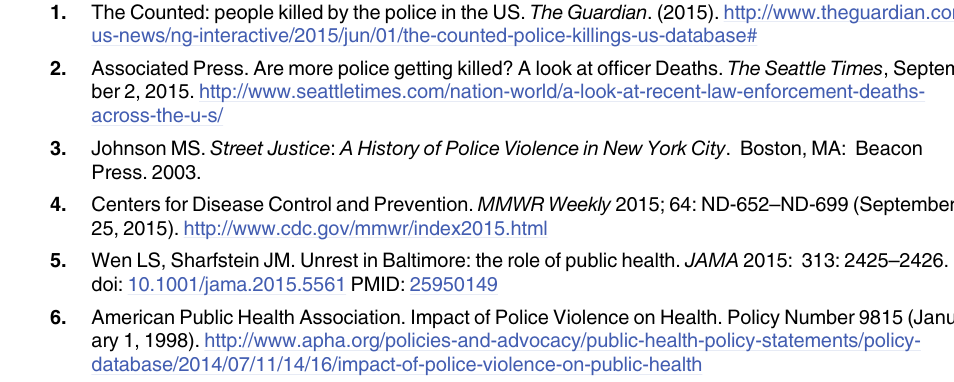
S2 Table. US deaths due to legal intervention: national and city-specific 5-year average annual rate (per 100,000) among US black men and white men ages 15 – 34, and rate ratios and differences: 1965, 1975, 1985, 1995, and